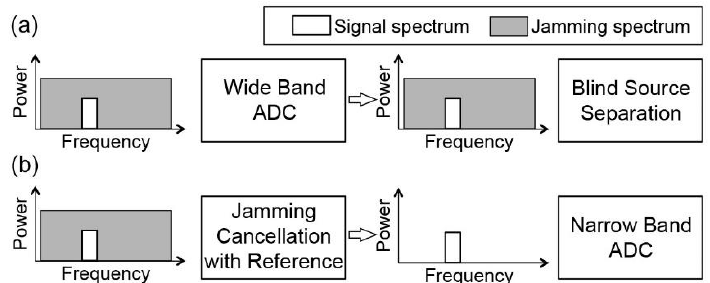
Figure 2. A comparison between ( a ) digital jamming cancellation and ( b ) analog jamming cancella- tion.